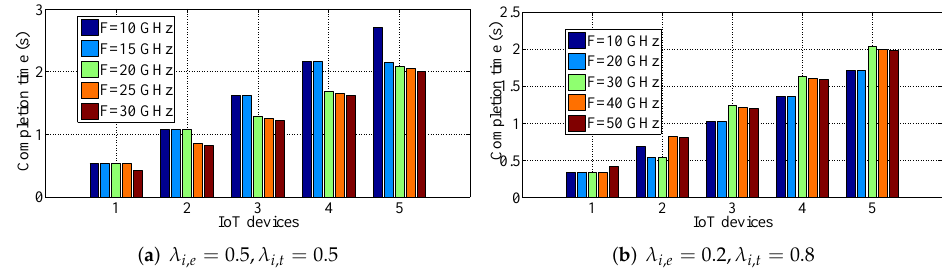
Figure 5. The effect of the edge cloud capacity on the application completion time. Figure 6a,b depict how the edge cloud capacity affects the consumed energy under different values of weight coefficient. By comparing the two figures, we observe that the consumed energy for each IoT device in Figure 6a is lower than that in Figure 6b. This is owing to the fact that the coefficient value of λ i , e is bigger in Figure 6a.